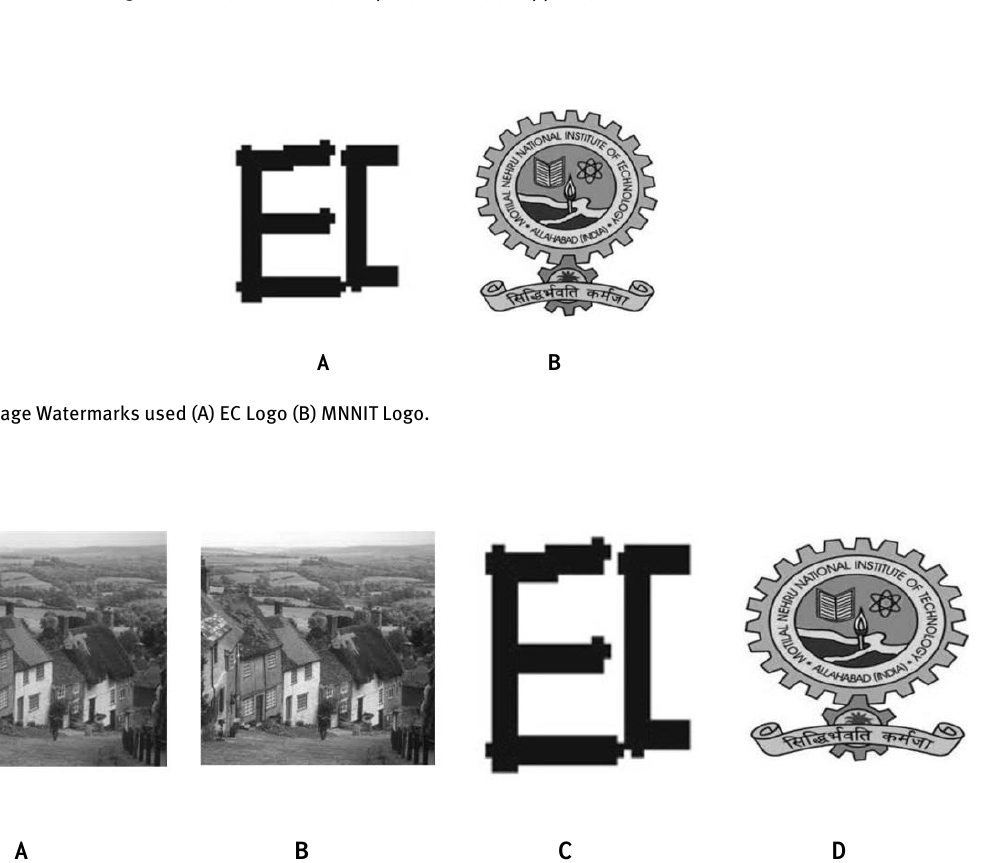
Mean squared error (MSE), peak signal to noise ratio (PSNR), normalized correlation (NC) [51],